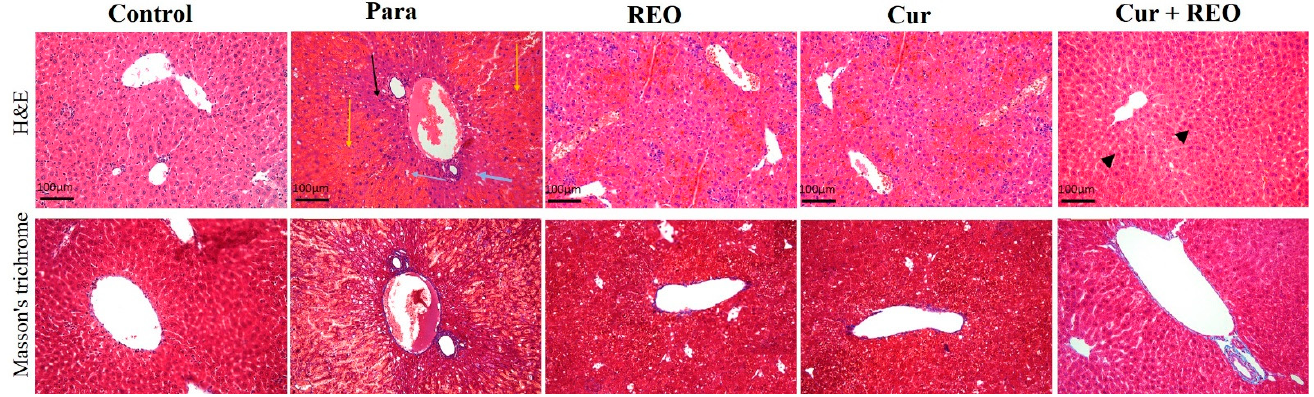
Figure 3. The effect of pretreatment with curcumin (Cur) and rosemary essential oil (REO) on histopathological changes in paracetamol (Para) induced liver toxicity in mice.